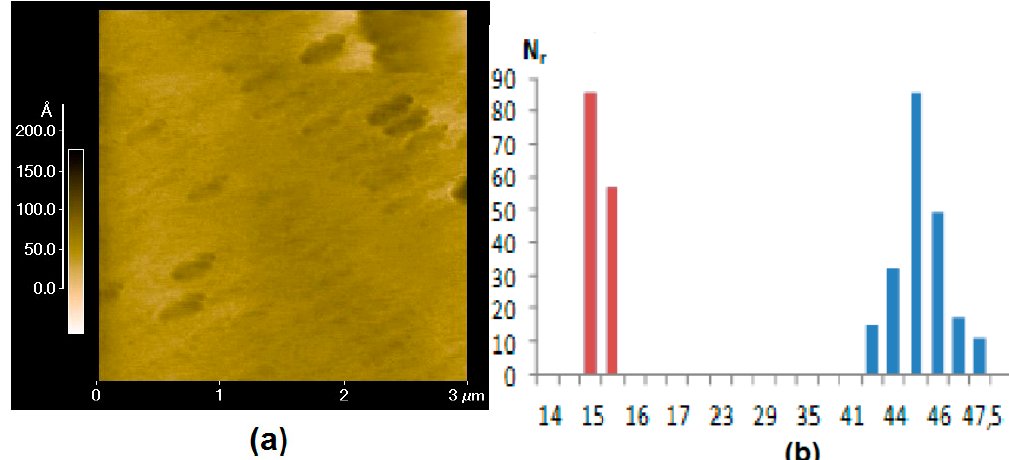
Figure 8. Atomic force microscopy (AFM) image (tapping mode) of the sample of the hybrid metal– mesogenic nanosystem “Ag—4-cyano-4 ′ -pentylbiphenyl” (1/10 w/w%) in nematic phase 4-cyano-4 ′ - pentylbiphenyl (left) ( a ) and a histogram of the size distribution (right) for the silver nanoparticles ( b ). Red—cross size of nanoparticles, blue—linear length of nanoparticles. (cid:48) The use of higher homology 4-cyano-4 -octylbiphenyl (8CB) smectic liquid crystal 8CB as a soft